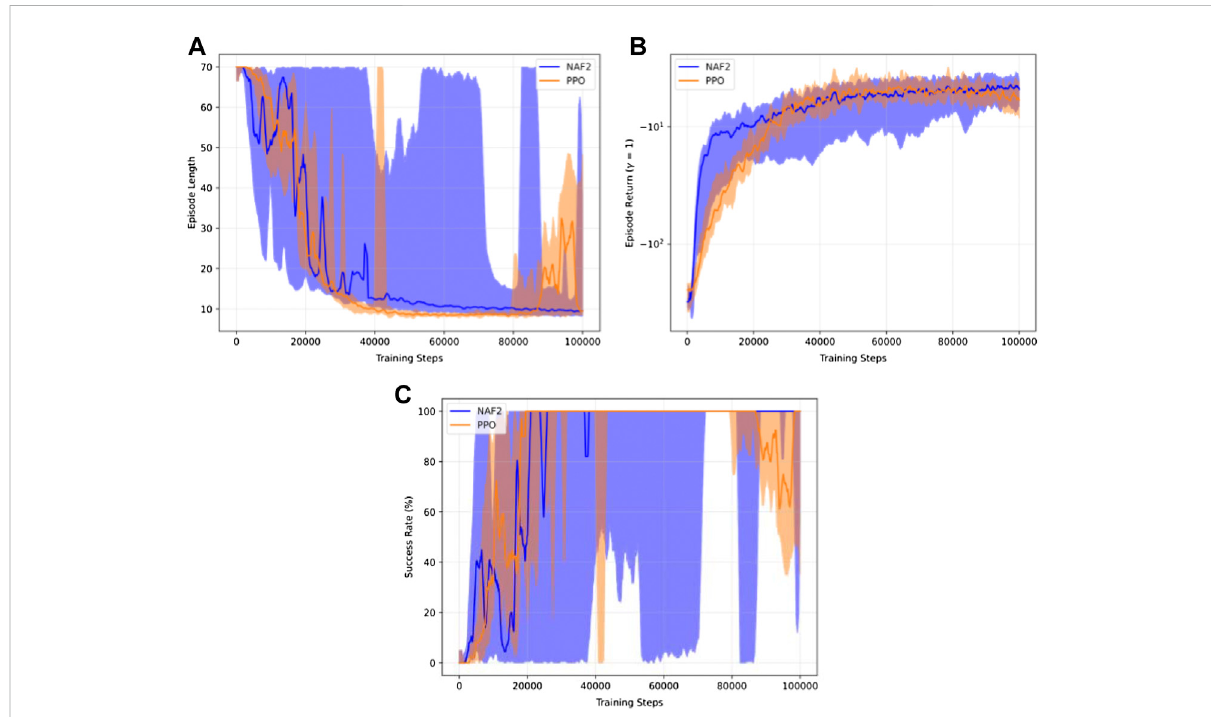
FIGURE 3 PerformancestatisticsofNAF2andPPOagentsduringtraining.ThehyperparametersusedaretabulatedinTable2andTable3,respectively. (A) Median episode length; (B) Median undiscounted episode return and; (C) Median success rate, of fi ve agents initialised with different random seeds, per